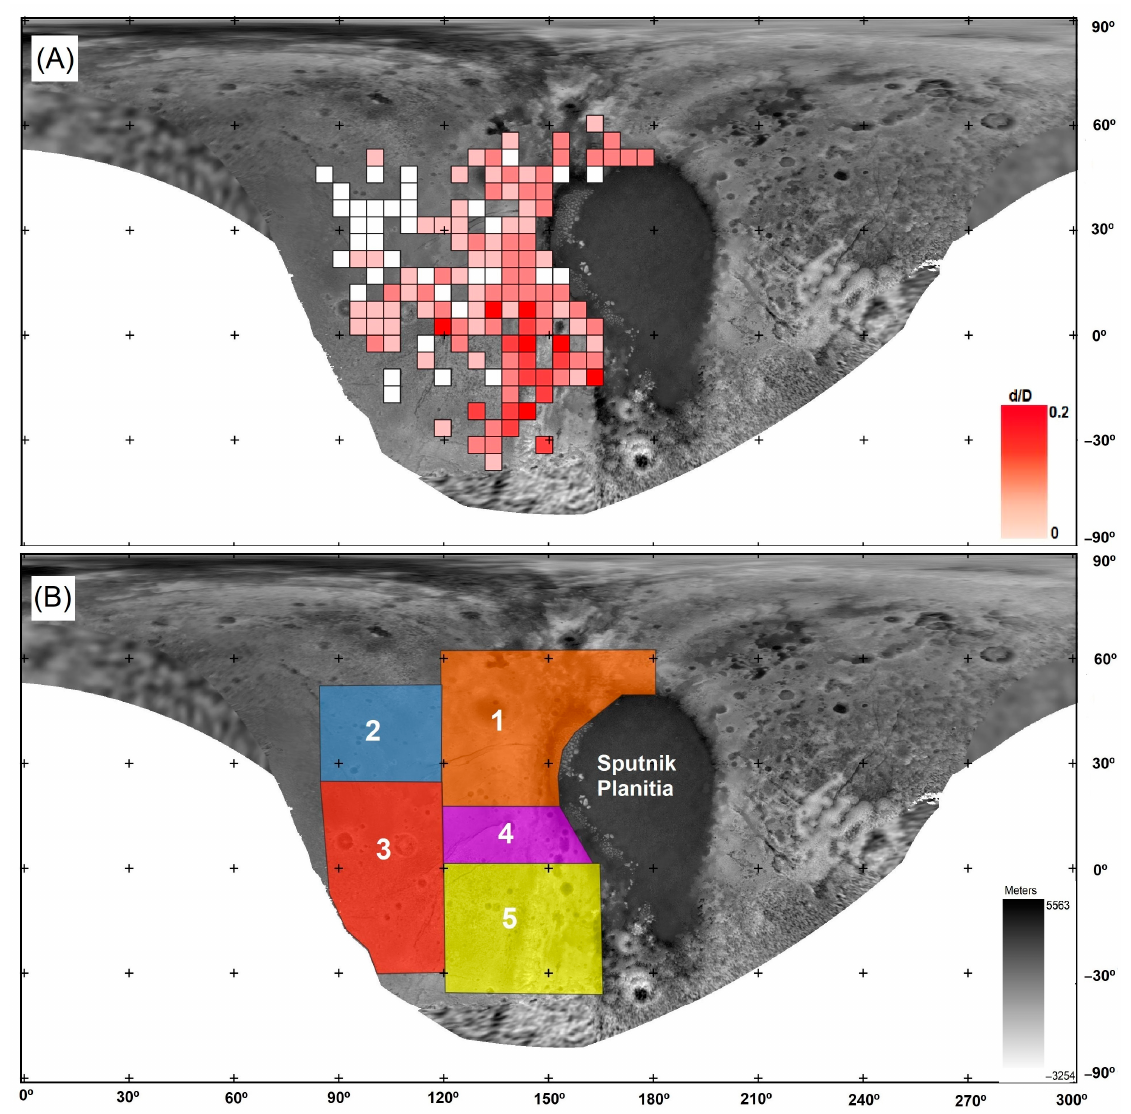
Figure 6. ( A ) Heatmap showing bins of 100 km² with mean values of d/D ratios. Bins with no craters are not considered. ( B ) Areas dividing Pluto’s surface into five groups.